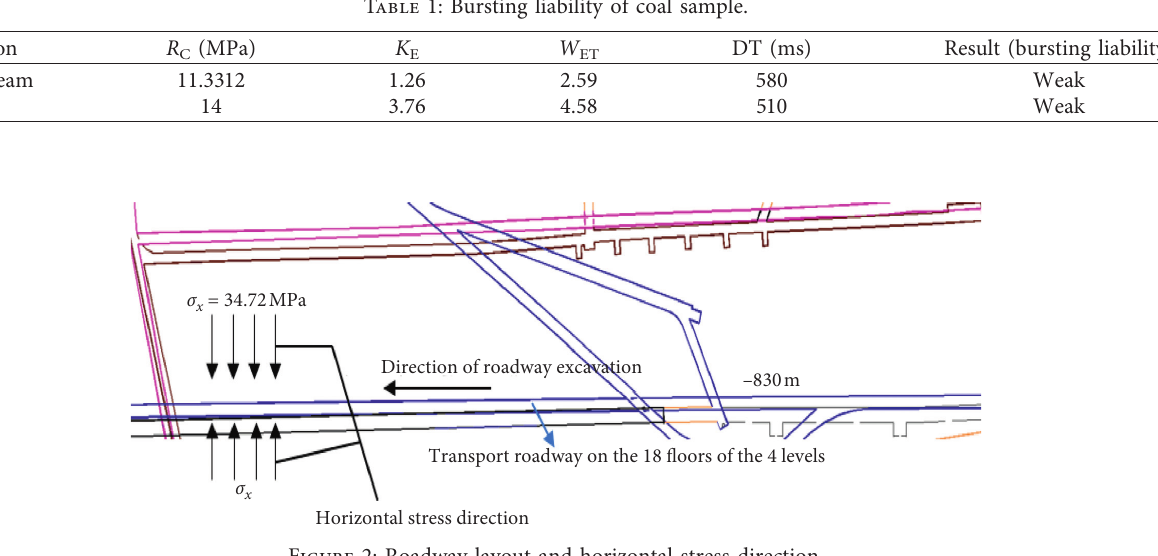
Figure 2: Roadway layout and horizontal stress direction.